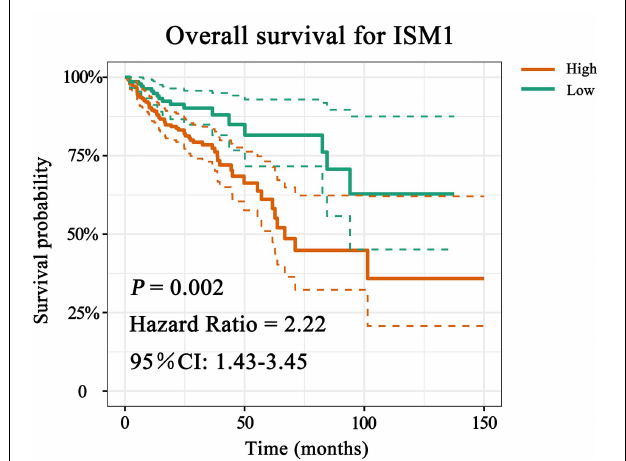
FIGURE 3 | Overall survival (OS) analysis of ISM1. The expression of ISM1 was significantly related to OS in TCGA-CRC cohort. Yellowish brown indicates high ISM1 expression, while dark green indicates low expression. Dotted lines represent confidence intervals. The horizontal axis indicates OS time (months), and the vertical axis is survival probability. P < 0.05 is statistically significant.